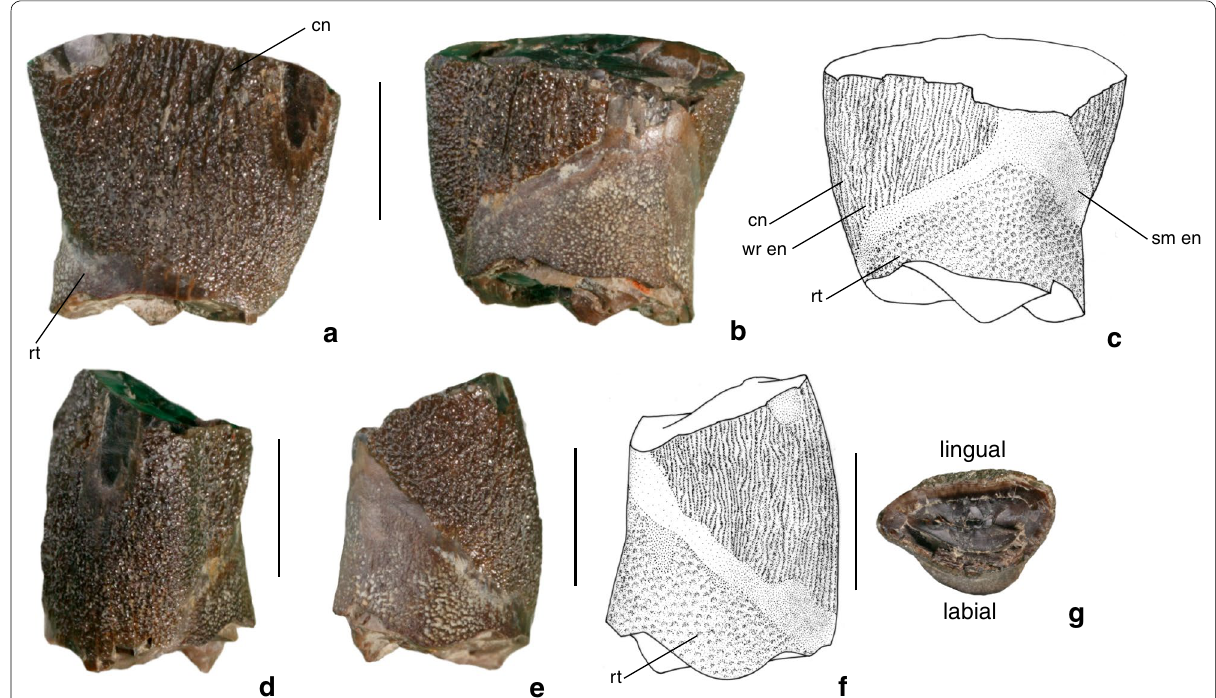
Fig. 3 Tooth NMB M.H. 451 of A. greppini . a lingual, b labial aspect, c line drawing of labial aspect, d distal (?) aspect, e mesial (?) aspect, f line drawing of same mesial (?) aspect, g apical view showing outline in cross-section. Scale bar is 5 mm. Drawings by Serafin Padzera. cn tooth crown, rt tooth root, sm en smooth enamel, wr en wrinkled